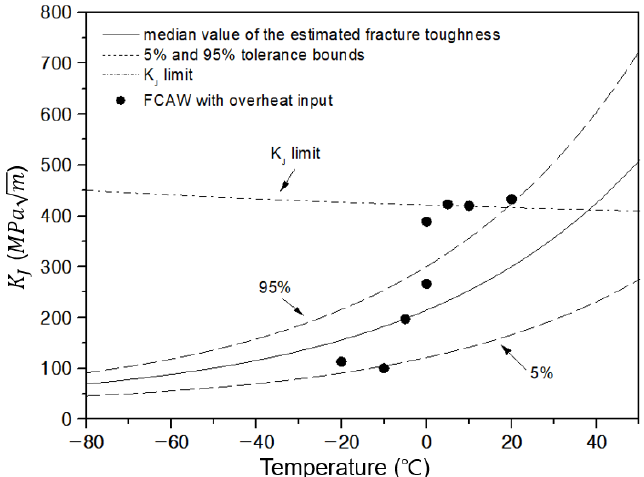
Figure 13. Master curve for FCAW, overheat input condition with CTOD test results.